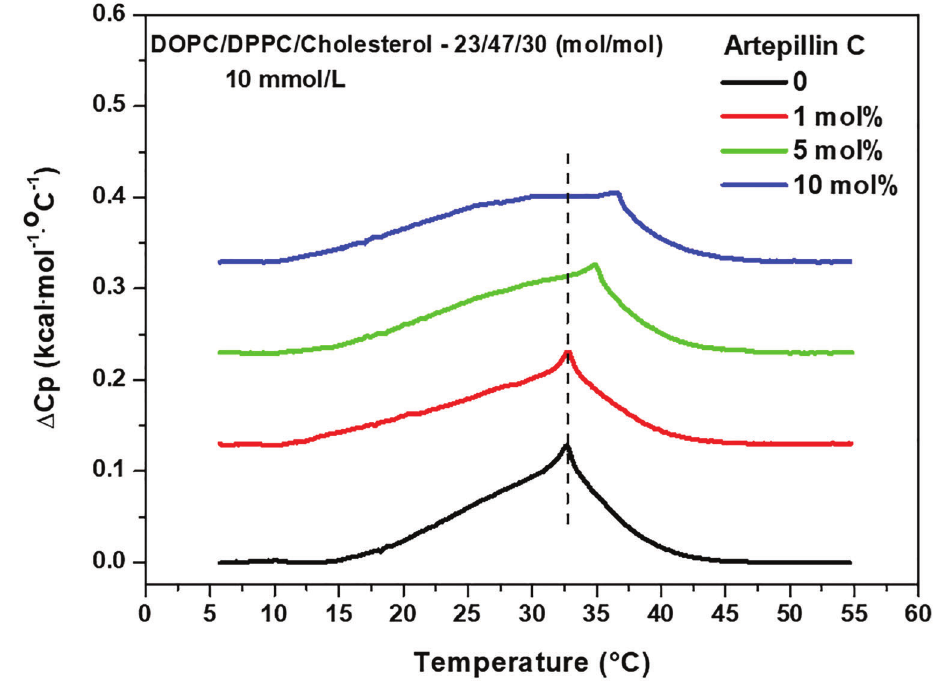
Figure 1. Differential scanning calorimetry thermotropic curves of lipid suspension (10 mM) of multilamellar vesicles formed of DOPC/DPPC/ cholesterol (23:47:30 molar ratio), in the absence and presence of 1, 5, and 10 mol% of artepillin C. Temperature range was from 5 to 55°C. Table 1. Thermodynamic data obtained from differential scanning calorimetry measurements of DOPC/ DPPC/cholesterol (23:47:30 molar ratio), 10 mM, in the absence and presence of artepillin C-inserted vesicles (1, 5, and 10 mol%).